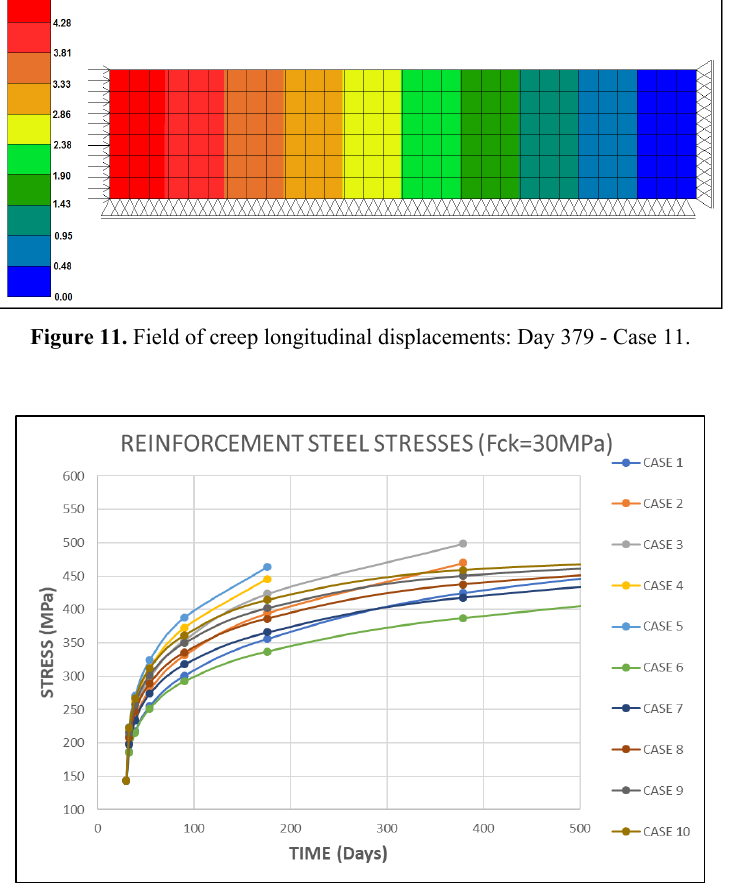
Figure 12. Stresses evolution on the reinforcement bars - C30